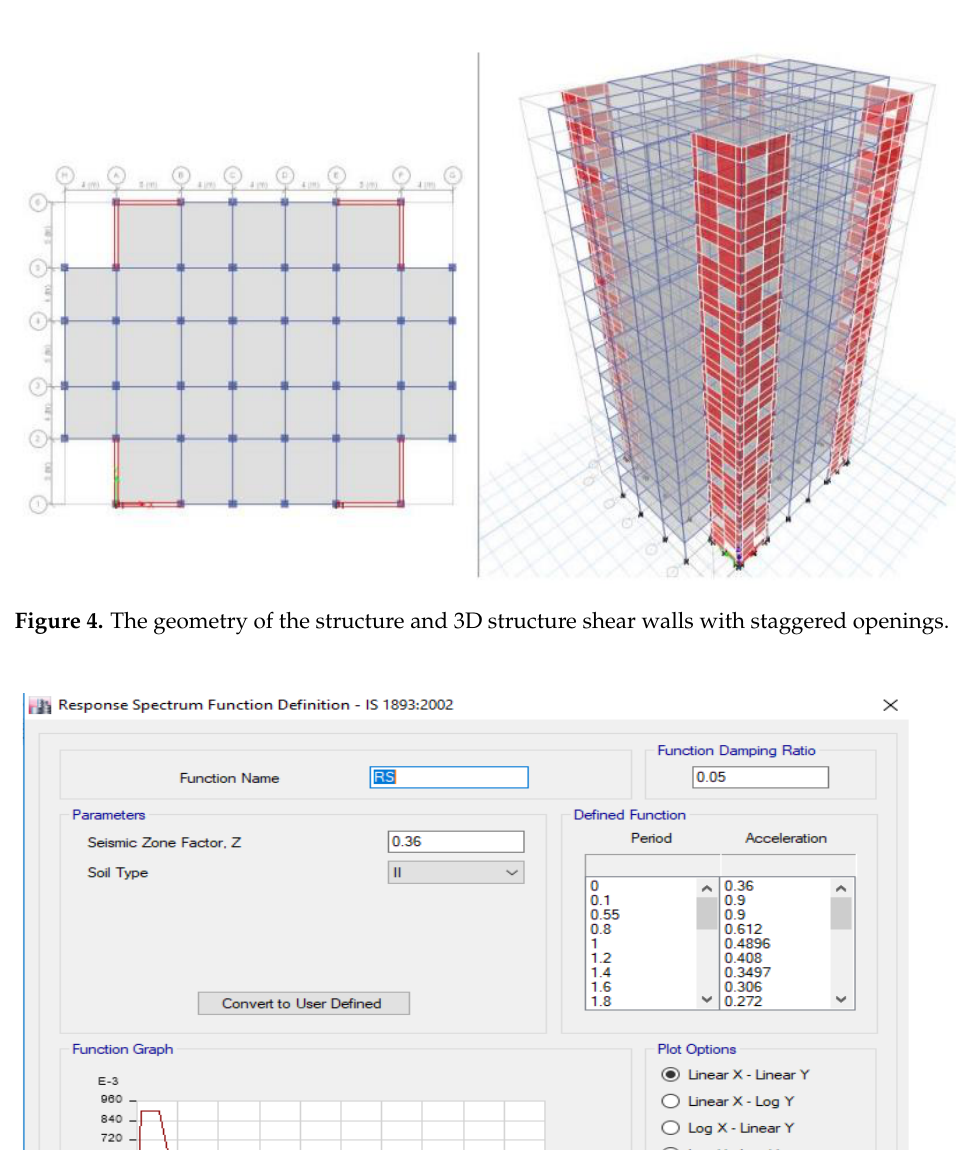
Figure 4. The geometry of the structure and 3D structure shear walls with staggered openings.